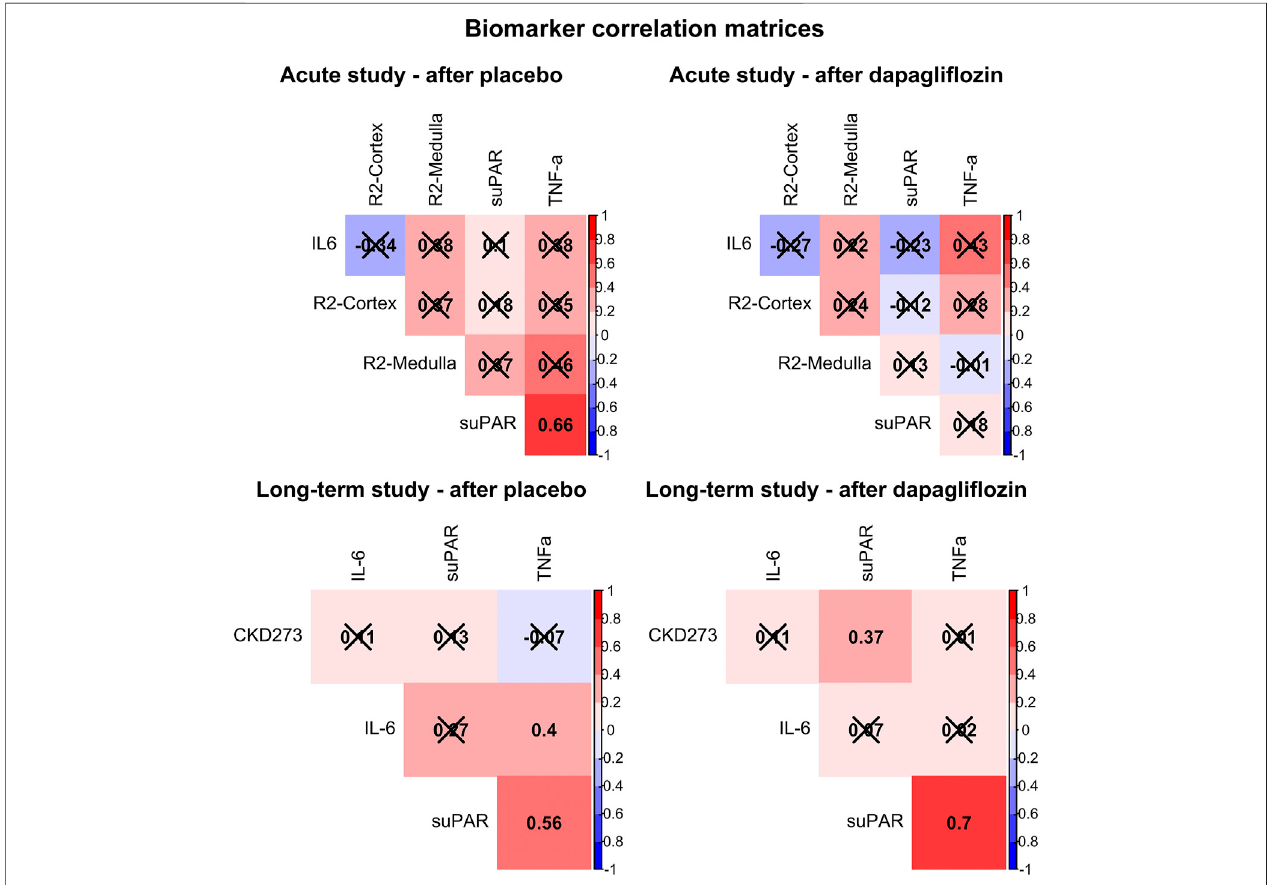
FIGURE 2 | Correlation matrices showing Pearson ’ s R for all associations between soluble urokinase plasminogen activator receptor (suPAR), interleukin 6 (IL6), tumor necrosis factor alpha (TNF-a), and the primary outcomes for each trial (cortical renal oxygenation (R2-Cortex) and medullary renal oxygenation (R2-Medulla), and the CKD273 classi fi er, respectively), after treatment with placebo and dapagli fl ozin. Non-signi fi cant correlations are crossed over. Positive correlations are colored red, and negative colored blue.